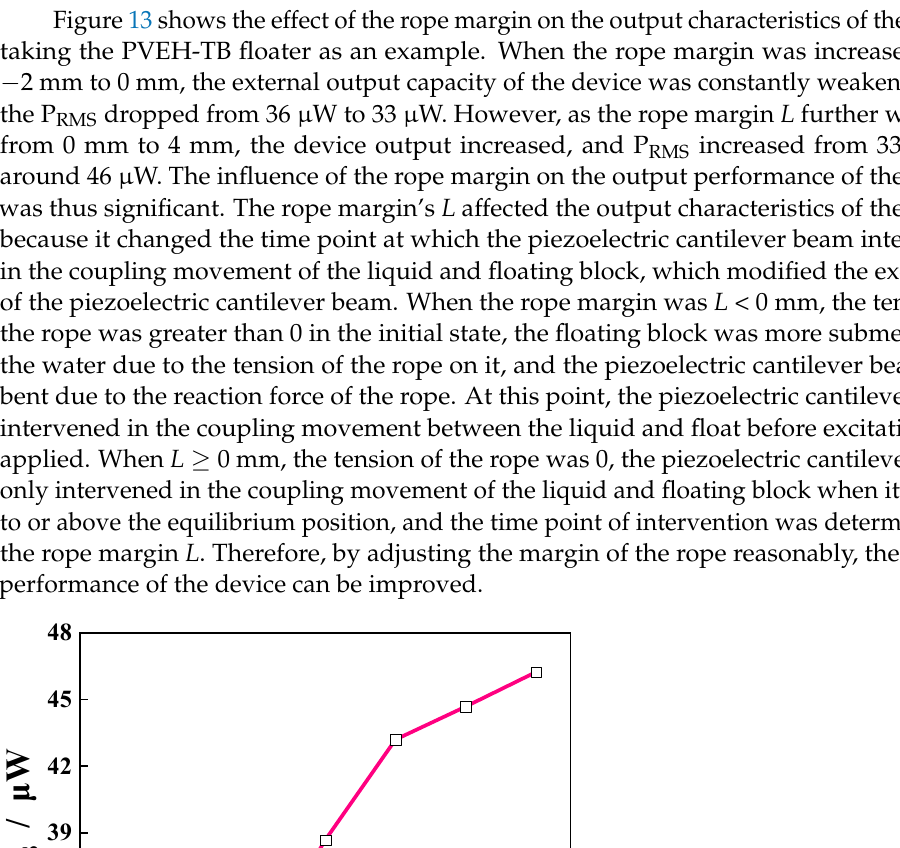
Figure 12. The effect of float shape on the PVEH output characteristics.